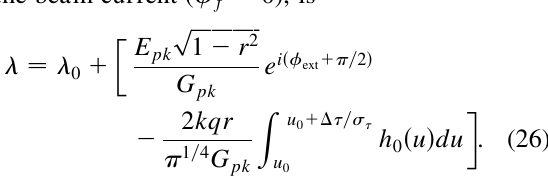
FIG. 4. Laser pulse shapes for r (cid:1) 1 and different beam charges. This calculation was performed with (cid:3) (cid:29)! (cid:1) (cid:2) 2 : 5 , , and (cid:29) (cid:24) (cid:1) 5 , 1 (cid:7) 10 4 , (cid:24) (cid:24) 0